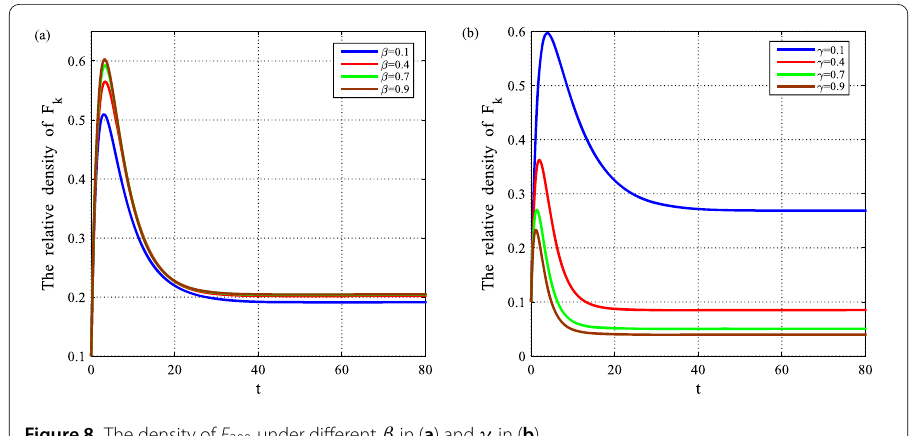
Figure 8 The density of F 200 under different β in ( a ) and γ in ( b